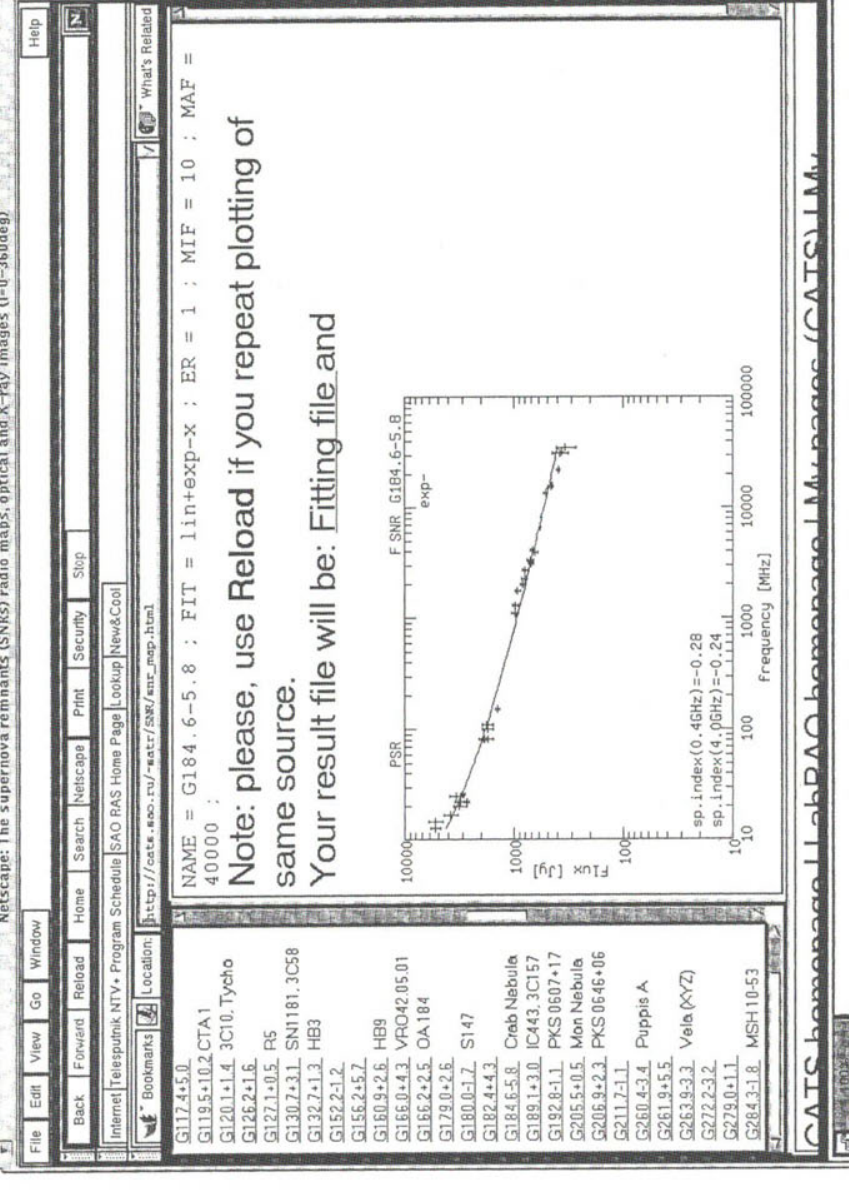
Fig. 1. The CATS frame with the "on-line" plot of the optical (VLT) image of the supernova remnant, Crab